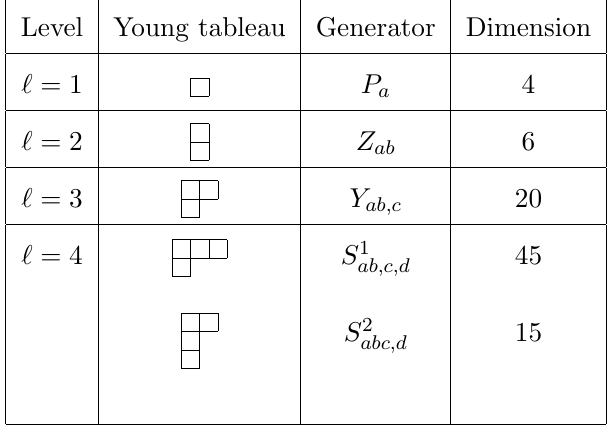
Table 2 . Summary of the positive level generators for Maxwell 4 in D = 4